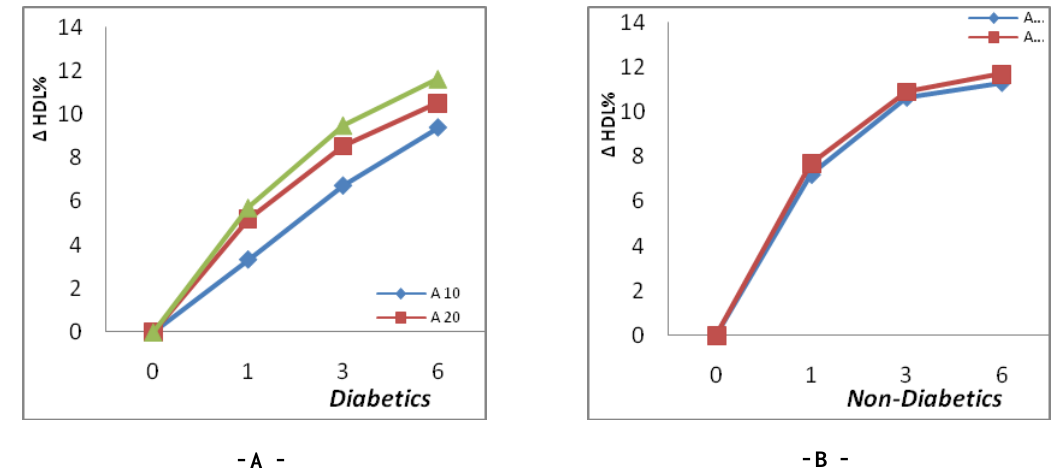
Figure 3 : Line chart showing percentage of serum hdl-cholesterol changes after treatment with atorvastatin in diabetics(A) &